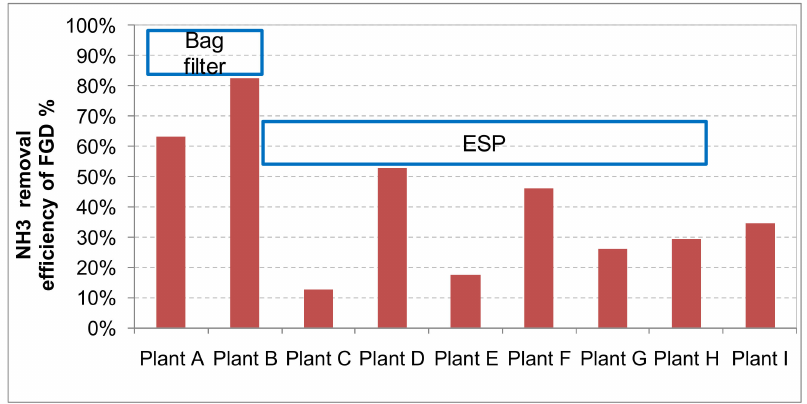
Figure 4. Ammonia removal e ffi ciency of electrostatic precipitator (ESP) and bag house.